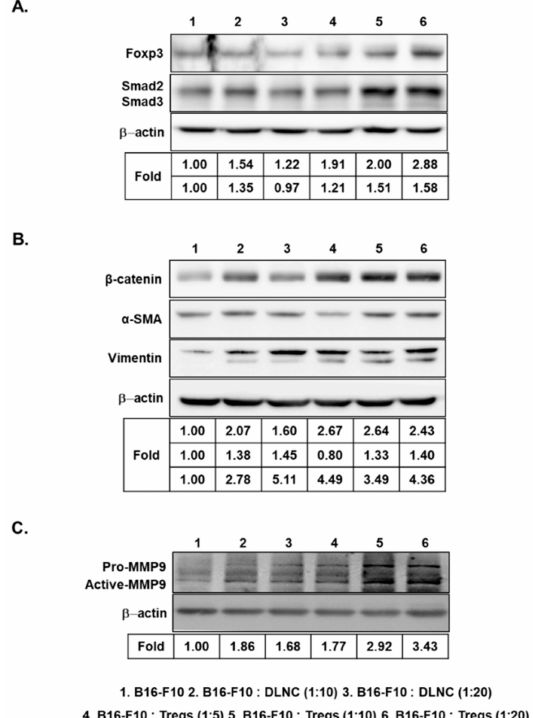
Figure 3. Increased expression of forkhead box P3 transcription factor (Foxp3), Smad2 / 3, epithelial–mesenchymal transition (EMT) markers, and matrix metalloproteinase 9 (MMP9) in B16-F10 cells following co-culture with Tregs. Representative Western blot analysis of Foxp3 and Smad2 / 3 ( A ), mesenchymal markers ( β -catenin, alpha-smooth muscle actin ( α -SMA), and vimentin) ( B ), and pro- and active-MMP9 ( C ) from the B16-F10 cell lysate harvested at 72 h after the initiation of co-culturing with DLNC or Tregs at various co-culture